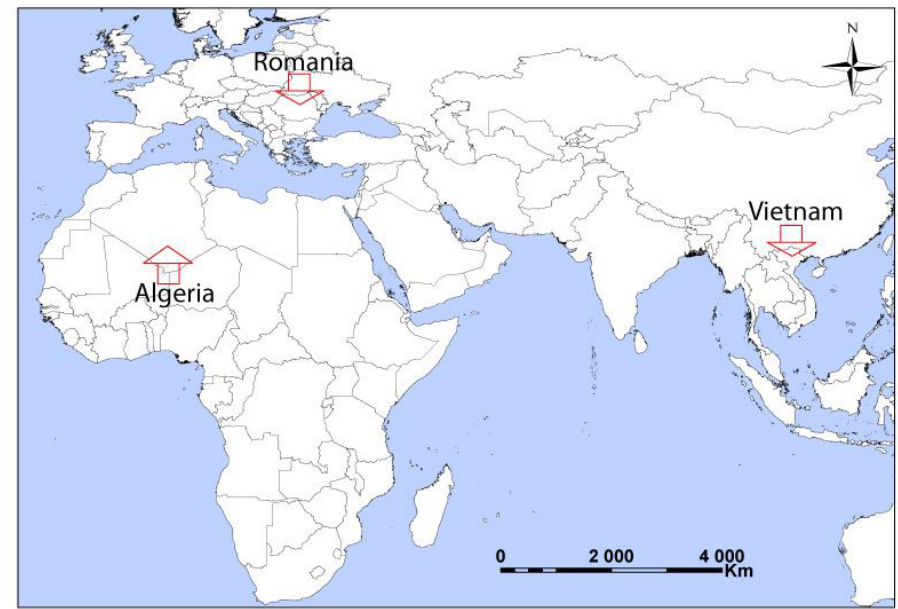
Figure 1. Location of the three case studies in the world. Source: made by A.-I.P. using ESRI ArcView data. ArcView